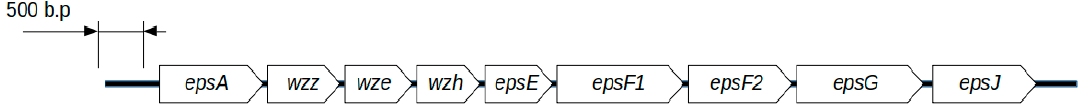
Figure 2. The genetic cluster related to the synthesis of heteropolymer exopolysaccharides in L. helveticus D75 and D76. The location of the start of the genetic cluster in L. helveticus D75 is 284699.293492 bp, while, in L. helveticus D76, it is 1719263.1728034